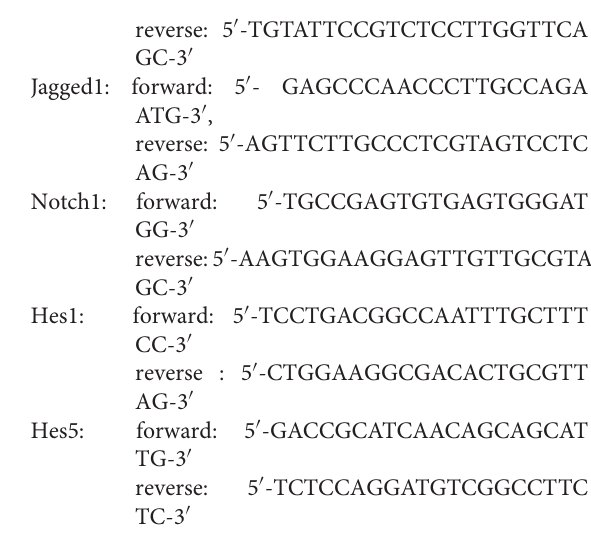
TABLE 1 | The body weight/random blood glucose/serum lipid level in different groups.